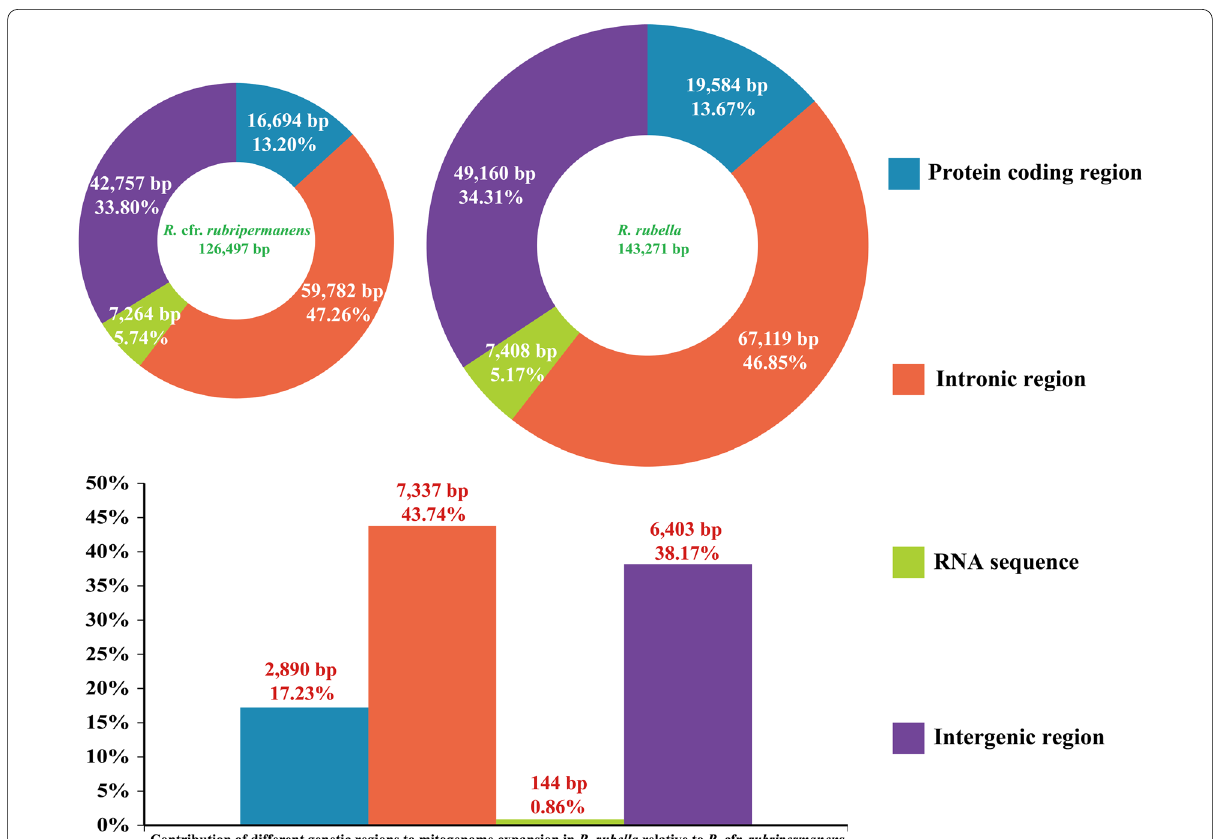
Fig. 3 Mitogenome composition of the two Ramaria mitochondrial genomes. The bottom panel shows the contribution of different gene regions to the expansion of the Ramaria rubella mitogenome. The y-axis represents the contribution rate of different regions to the size variation of the whole mitogenome, which is calculated by the following formula: size difference of region/size different of the entire mitogenome